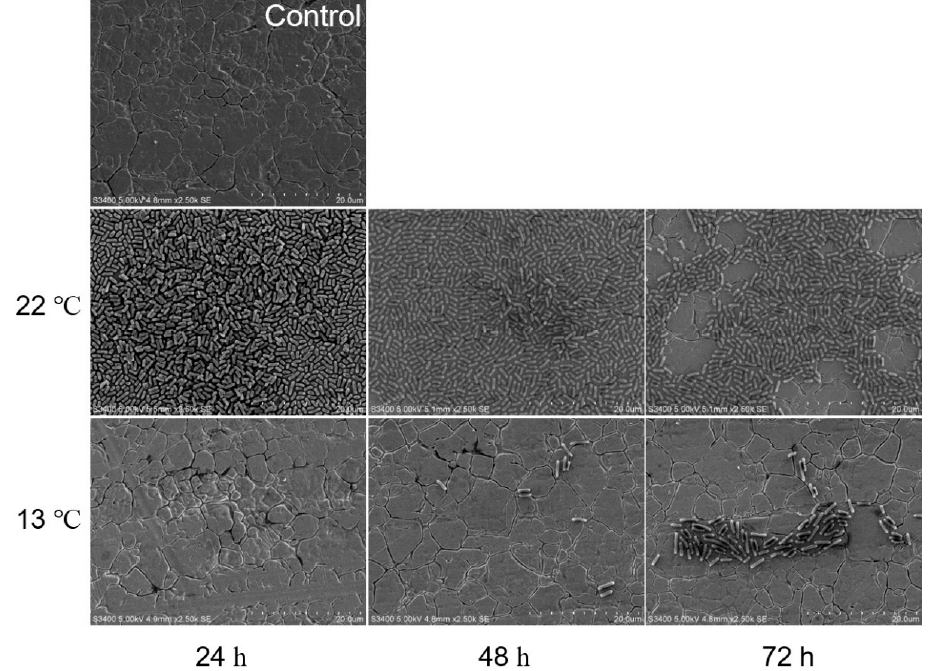
Figure 4. Representative SEM images of O145 biofilm grown in M9 medium at 22 °C and 13 °C for 24, 48, and 72 h on stainless steel coupons. Bar = 20 µm.